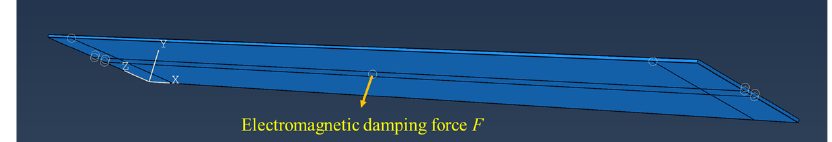
Figure 19. Schematic diagram of electromagnetic damping force loading.